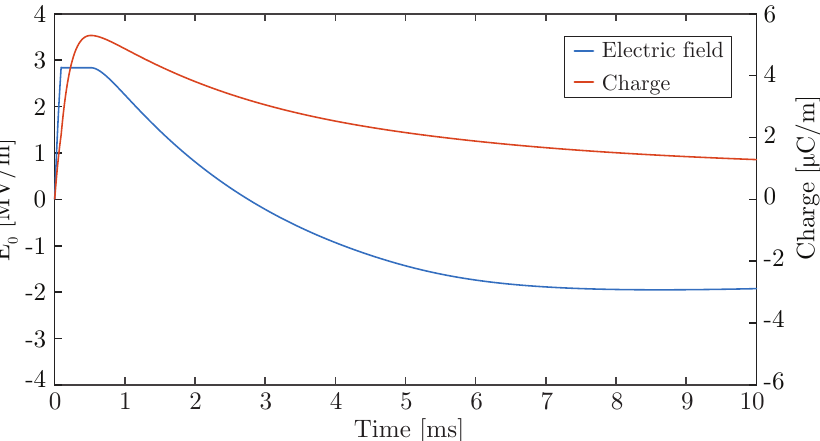
Figure 4. Correia de Barros’ model: space charge density ρ sp distribution at increasing distance from the conductor axis, as a function of time t and radial distance r . The applied voltage has a double exponential waveform (rise time 250 µ s, time-to-half value 2500 µ s) with peak value V max = 2 V inc . The trend of r inj is shown in red.